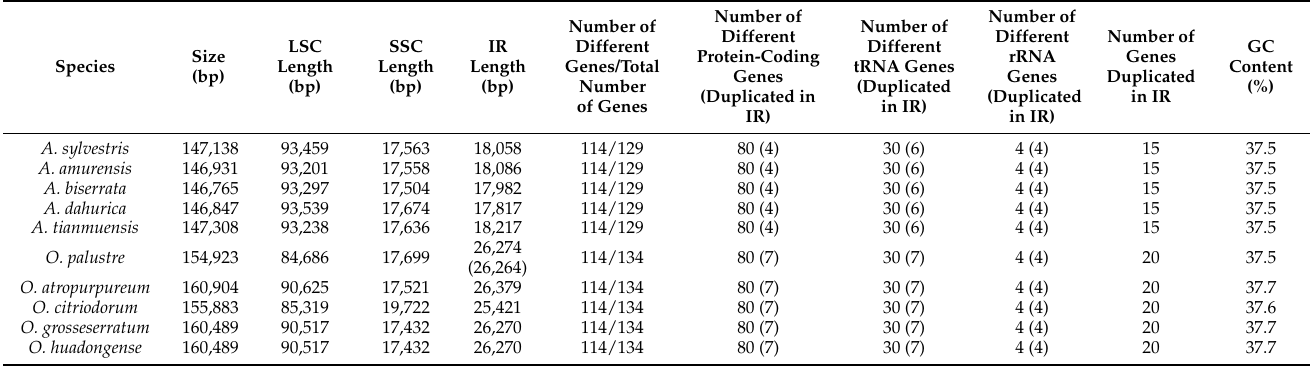
Table 1. Features of the plastid genomes of Angelica , Ostericum , and Pternopetalum